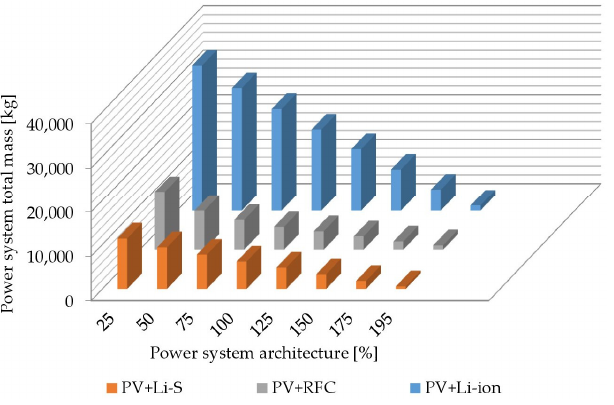
Figure 3. Total masses of photovoltaic (PV)-based power systems at varying solar illumination.